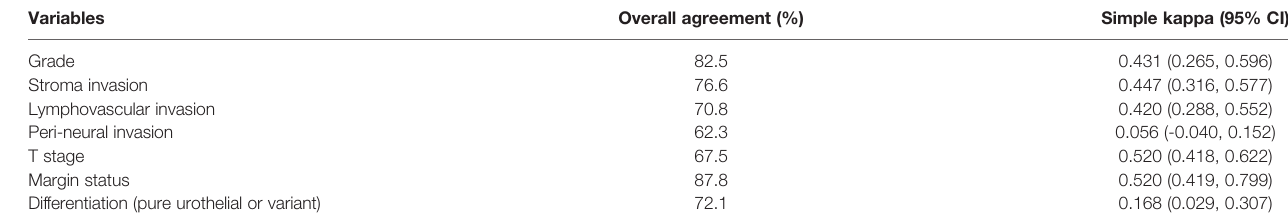
TABLE 6 | Agreements between review and local